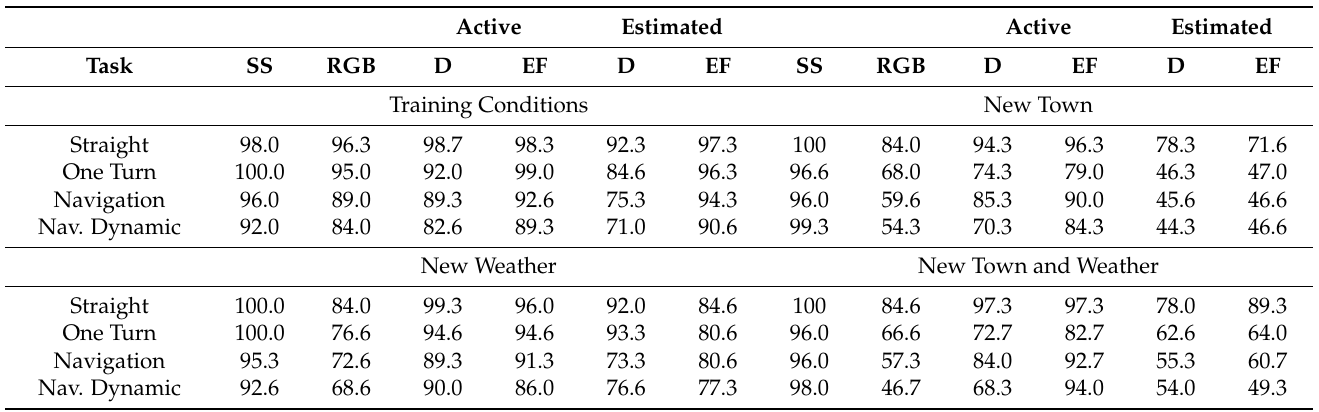
Table 3. Mean and Standard Deviation of Success Rate on the Original CARLA